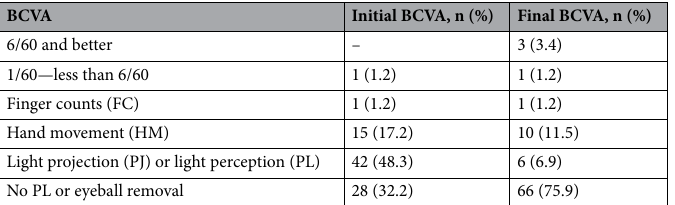
Table 3. Visual outcome of endophthalmitis associated with ocular surface infection in Siriraj hospital, Bangkok, Thailand. BCVA best corrected visual